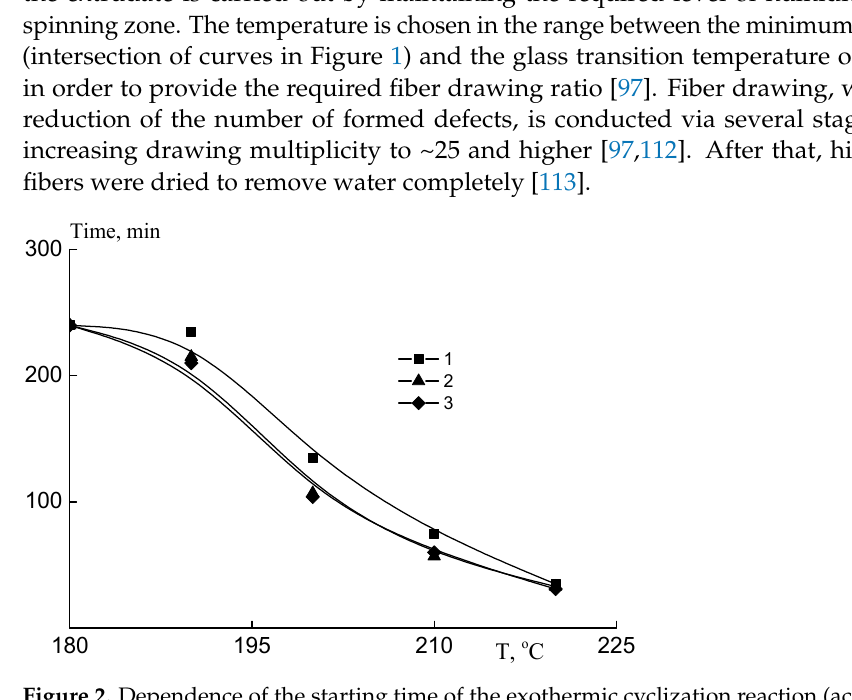
Figure 2. Dependence of the starting time of the exothermic cyclization reaction (according to DSC data) on the melting point of the copolymer AN and MA. Mass content of water 15 (1,2) and 20% (3), co-plasticizer 15 (1,2) and 10% (3); co-plasticizer: adiponitrile (1) and acetonitrile (2,3). According to